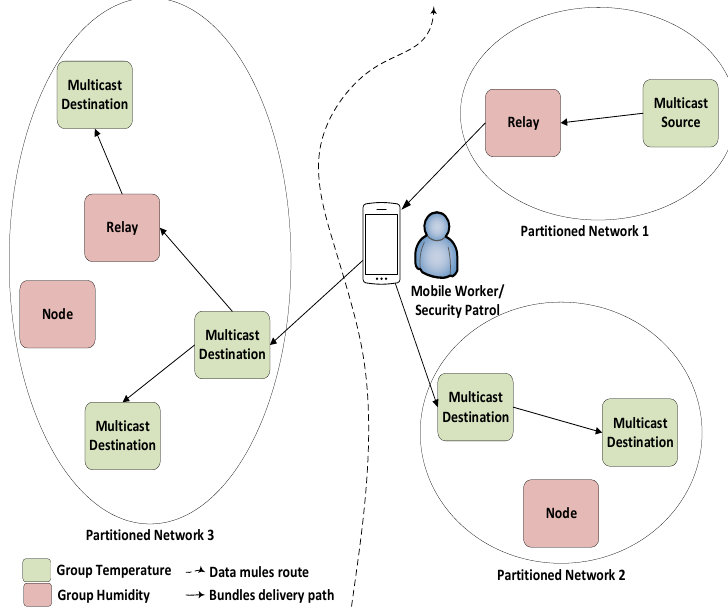
Figure 2 . Data mule in bridging partitioned networks. Figure 2. Data mule in bridging partitioned